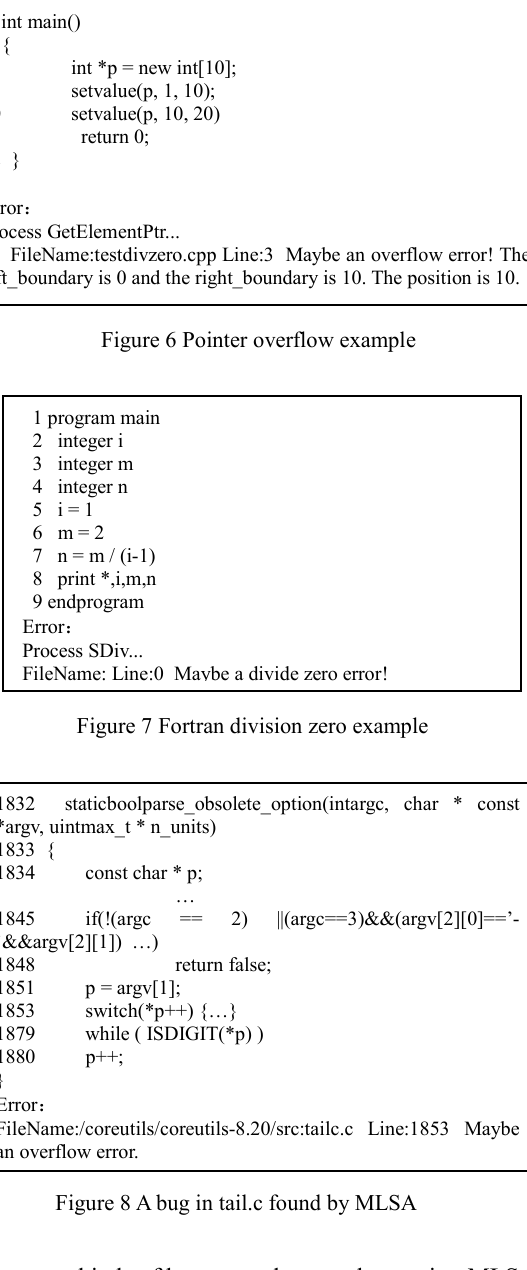
Figure 7 is a program written by Fortran language.